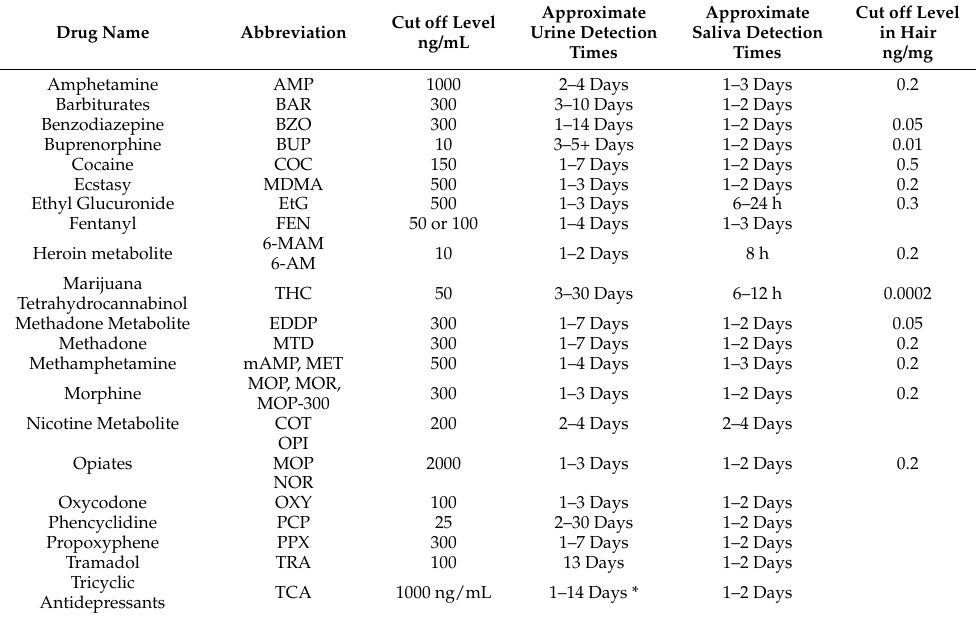
* detection times depend on specific substance, dose, frequency of use and body